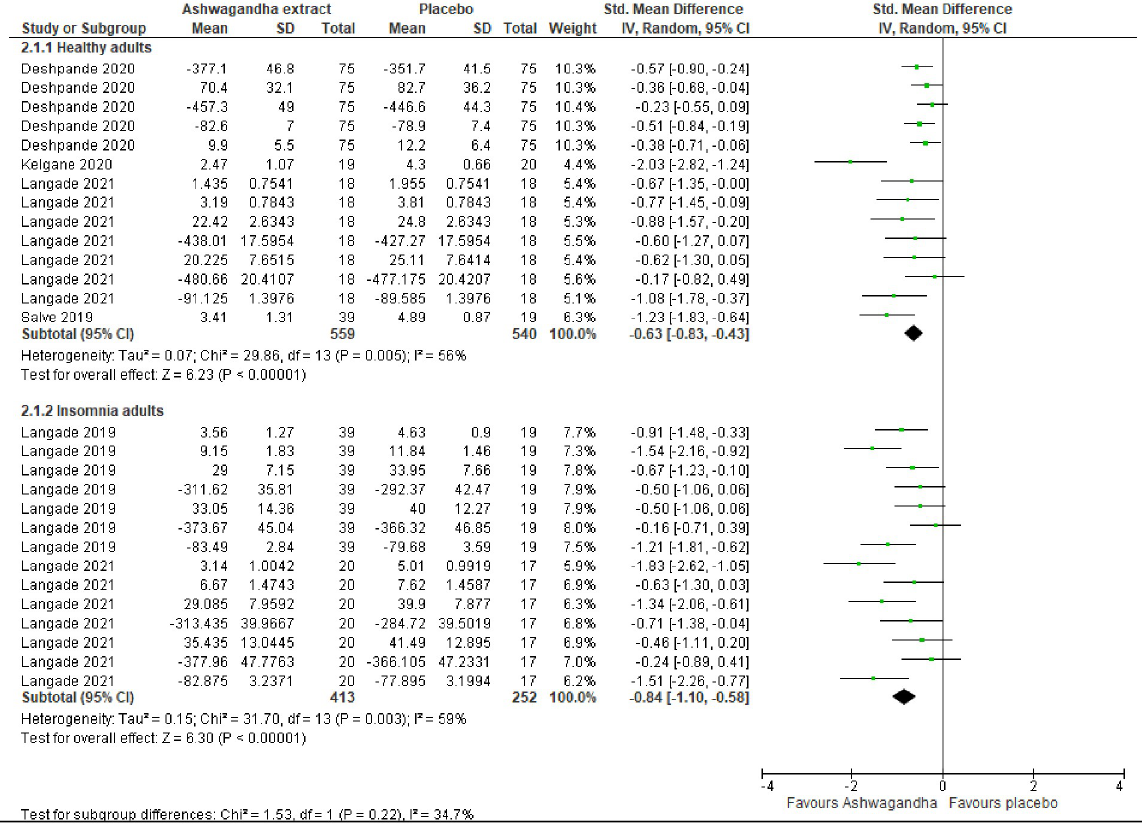
Fig 4. Forest plots of Ashwagandha versus placebo on sleep by participant’s background with or without insomnia.